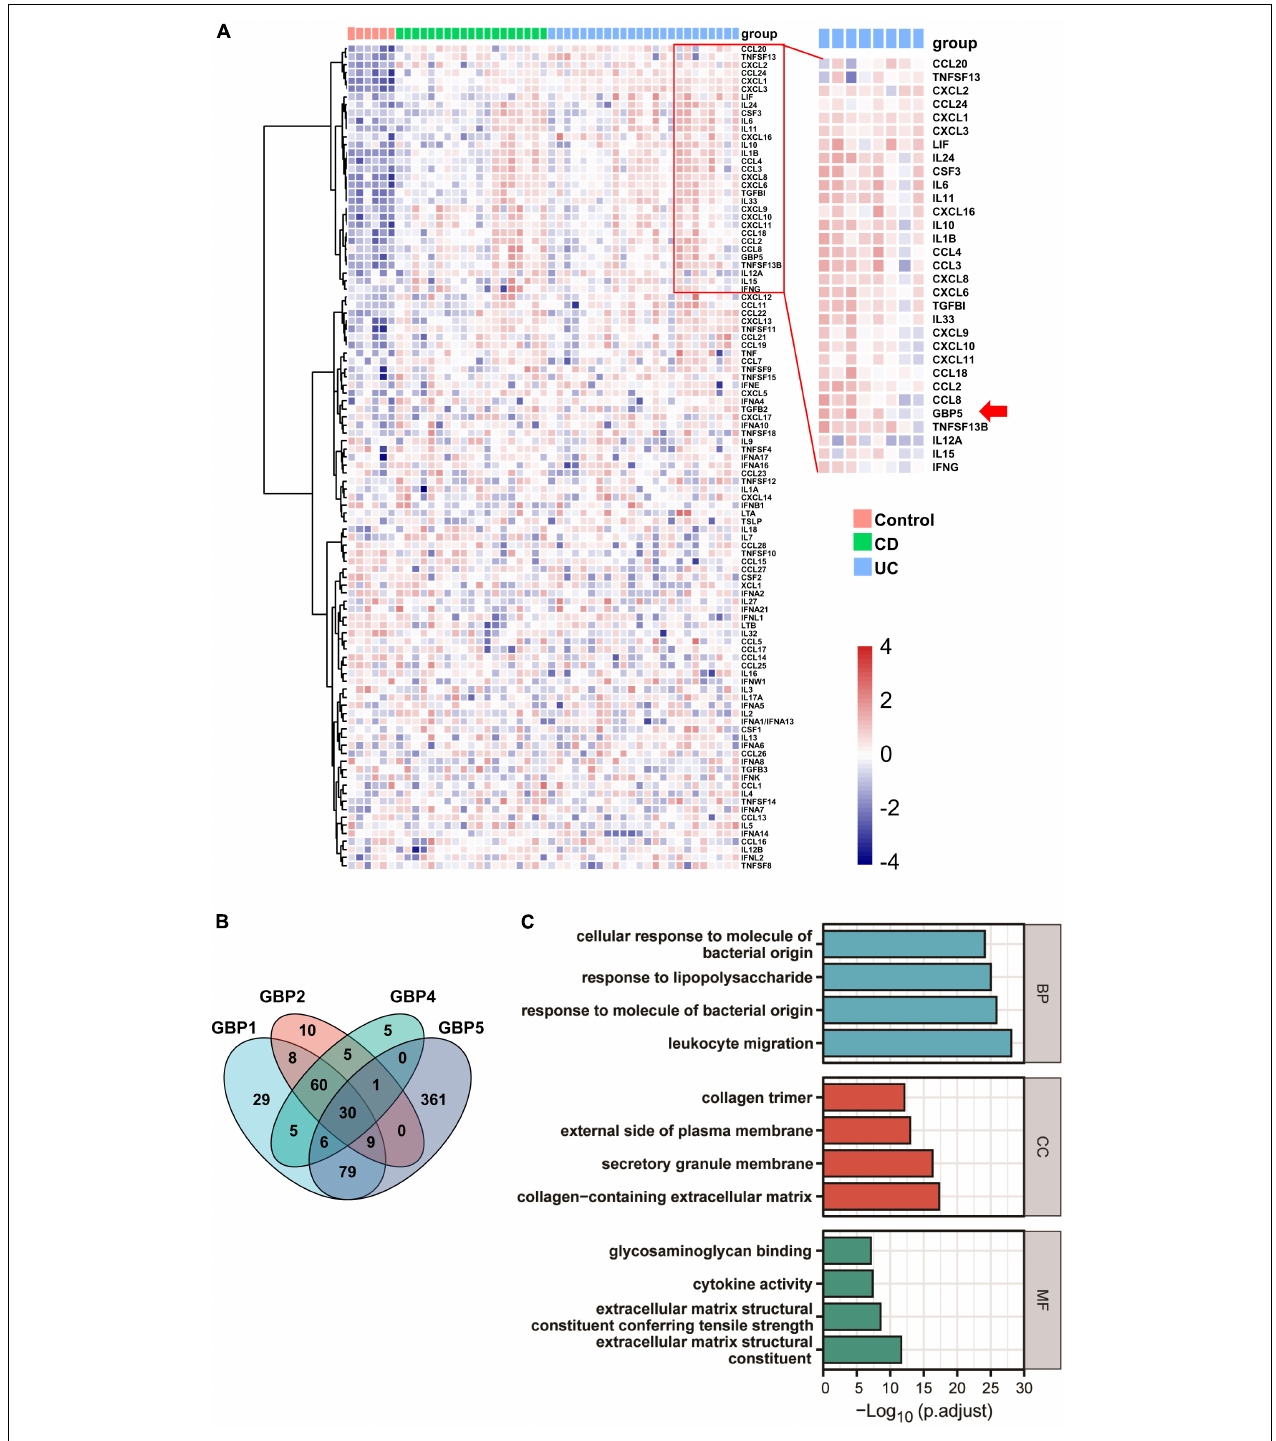
FIGURE 3 | GBP5 is implicated in inflammatory processes in IBD according to transcriptome analysis. (A) Heatmap for mRNA expression levels of GBP5 (arrow), available cytokines, and chemokines based on transcriptome data generated from colonic mucosal biopsies of healthy controls ( n = 6), patients with Crohn’s disease (CD, n = 19), and ulcerative colitis (UC, n = 24). Unsupervised hierarchical clustering of GBP5 , cytokine, and chemokine genes was performed. Genes in the red box are more closely clustered with GBP5. (B) Venn plot of the number of genes associated with GBP1, GBP2, GBP4, and GBP5, based on their mRNA expression levels. Associations with Pearson’s correlation coefficient no less than 0.6 are counted. (C) Gene Ontology (GO) analysis of GBP5 associated genes. The cutoff value for the input gene list is Pearson’s correlation coefficient no less than 0.6. BP, biological process; CC, cellular compartment; MF, molecular function. All samples from GSE16879 are included ( n =